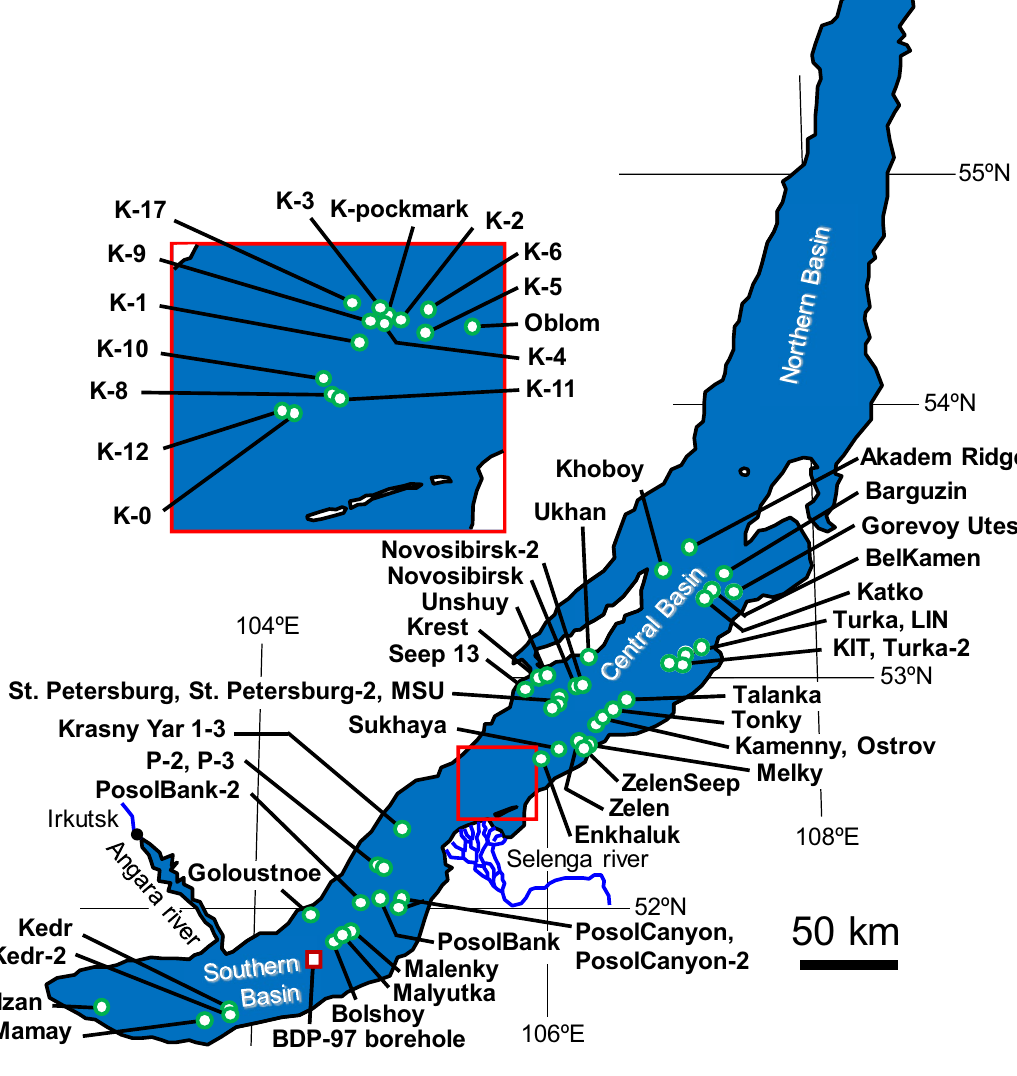
Figure 1. Locations of gas hydrate-bearing sites in Lake